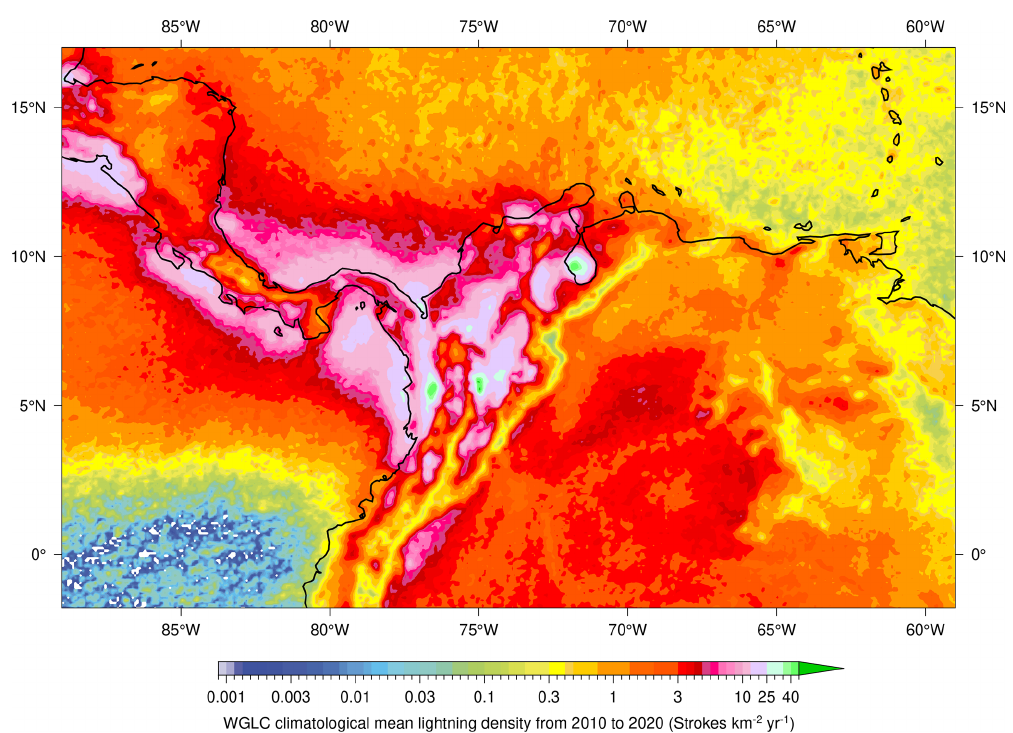
Figure 5. High-resolution (5arcmin) climatological mean annual lightning stroke density over northwestern South America and Central